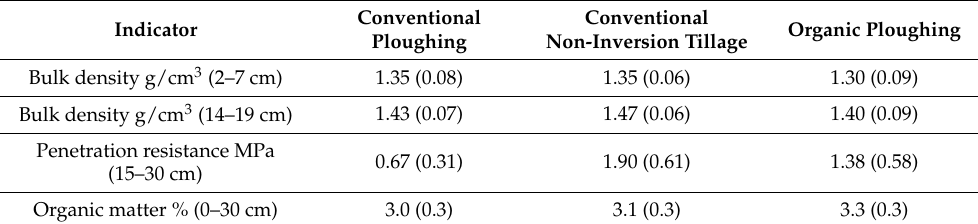
Table 1. Latest measured values for soil health indicators for systems’ conventional ploughing, conventional non-inversion tillage and ploughing in organic farming including standard deviations (between brackets). The latest measured values are used, since soil properties have changed over time. Measurements from 2015 and